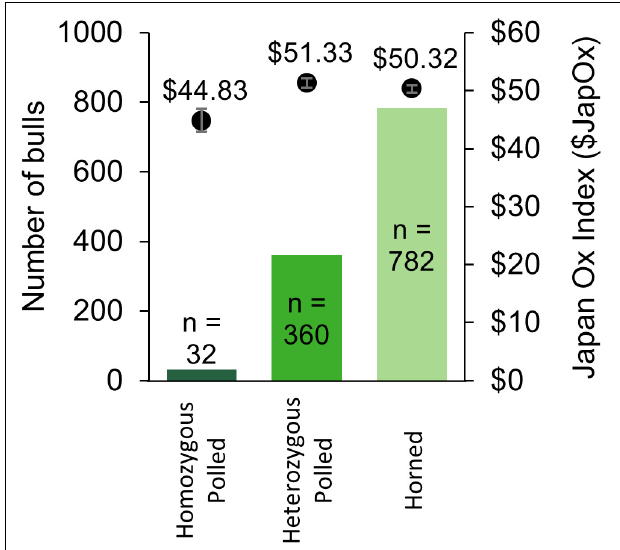
FIGURE 4 | Summary of Australian Brahman bulls with a SNP-based POLLED test (GeneSeek R (cid:13) ) result from 2014 to 2017. The number of bulls per genotype is on the primary y -axis (solid bars) and the average Japan Ox selection index ($JapOx) value of the top 20% of bulls per genotype is on the secondary y -axis (dots with error bars representing